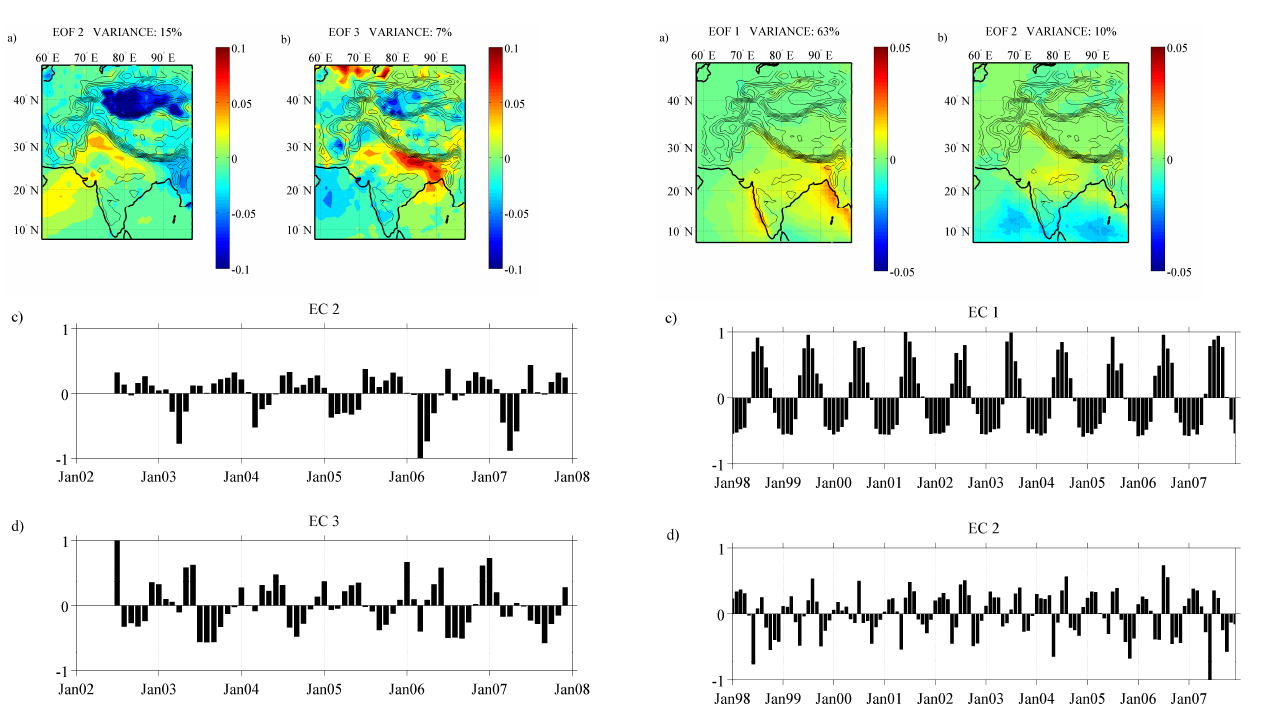
Fig. 7. (a, b) EOF 1 and EOF 2 obtained from the TRMM monthly Figure 7:a,b) EOF 1 and EOF 2 obtained from the TRMM monthly accumulated rainfall accumulated rainfall product. (c, d) EC1 and EC2 of the corre- product. c,d) EC1 and EC2 of the corresponding EOF1 and EOF2 of the TRMM rainfall sponding EOF1 and EOF2 of the TRMM rainfall respectively.